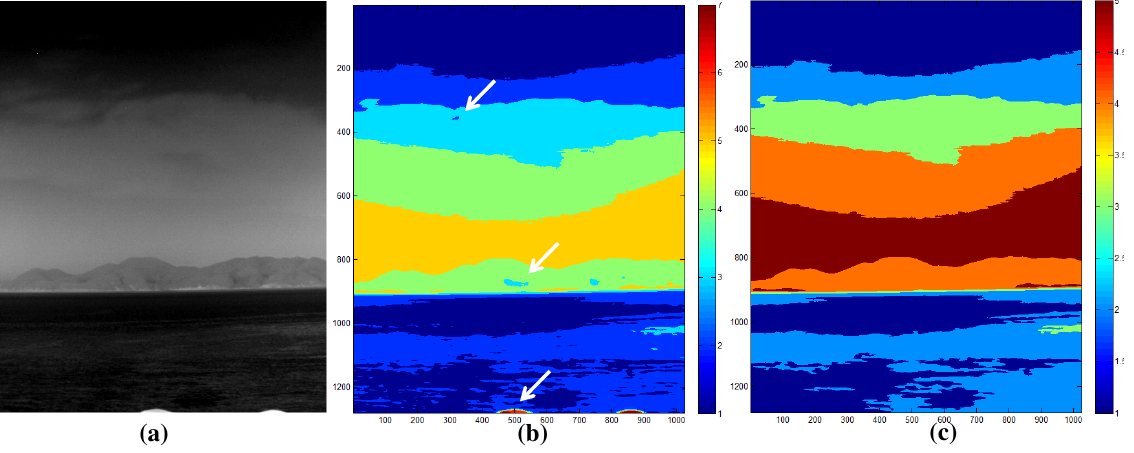
Figure 15. Results of the region map extraction: ( a ) test image; ( b ) original K-means clustering; ( c ) final region map.